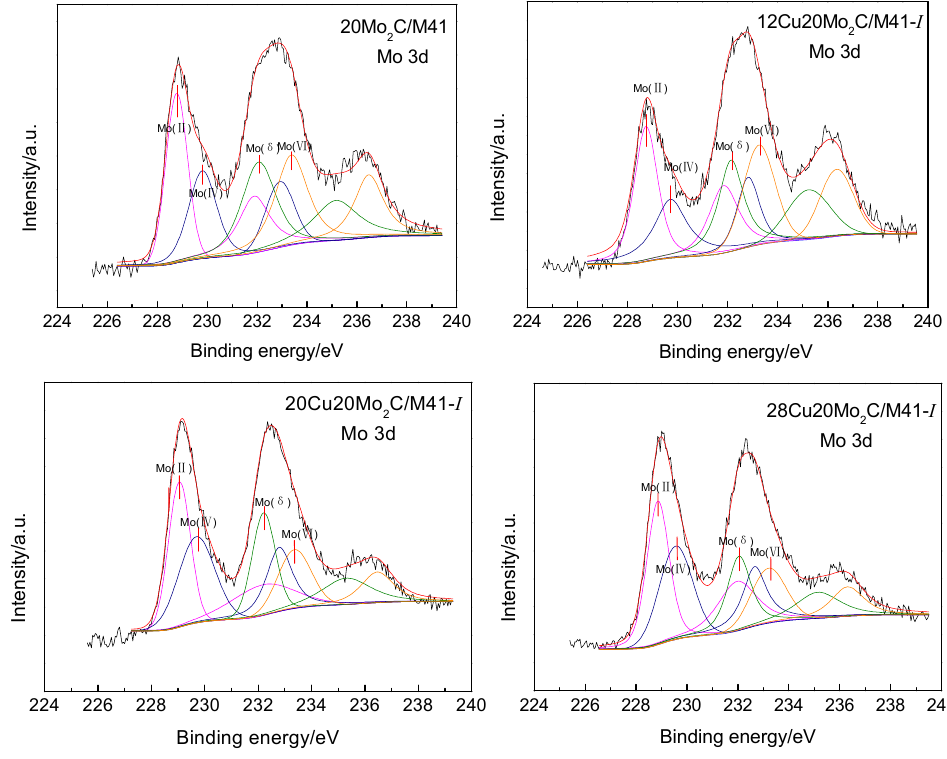
Figure 4. X ‐ ray photoelectron spectroscopy (XPS) spectra of 20Mo 2 C/M41 and x Cu20Mo 2 C/M41 ‐ I . Table 4. Mo 3d 5/2 binding energies and (Mo IV + Mo δ )/Mo total ratios of 20Mo 2 C/M41 and x Cu20Mo 2 C/M41 ‐ I .